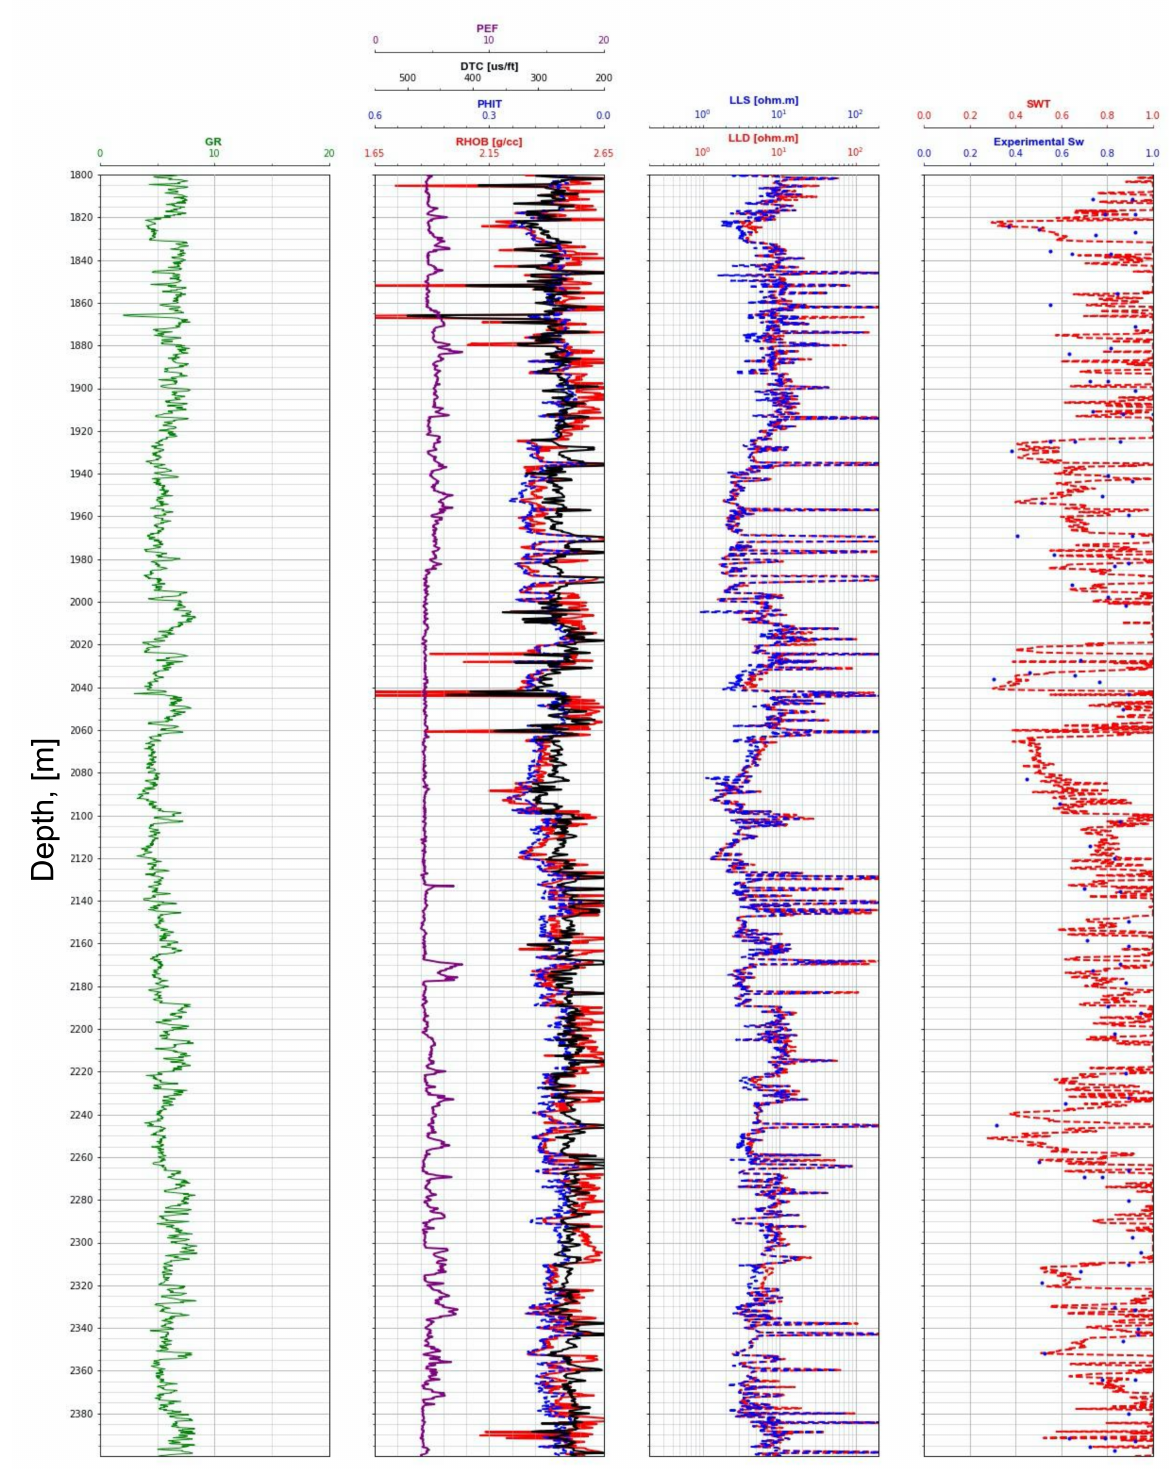
Figure 3. Petrophysical well log data from a representative well in the study area. From left to right, track 1 represents gamma ray, track 2 represents bulk density log in red, neutron density in blue, sonic log in black and photoelectronic log in purple. Track 3 represents deep and shallow, resistivity logs in red and blue, respectively. These logs are the input for the proposed models to predict water saturation as shown in Track 4 through the following parameters for the Archie equation: m = 1.49; n = 1.82; a = 1.532; R w = 0.35. blue dots in Track 4, are experimentally measured water saturation in the lab and red line is predicted water saturation by Archie’s